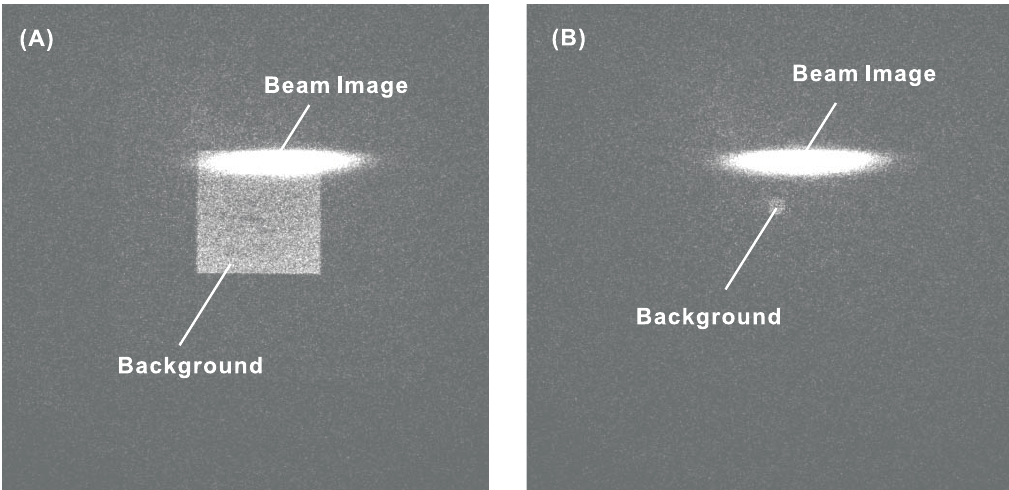
FIG. 9. CCD images of the beam profile and background (A) before and (B) after insertion of the x-ray mask with a pinhole diameter of 300 (cid:1) m